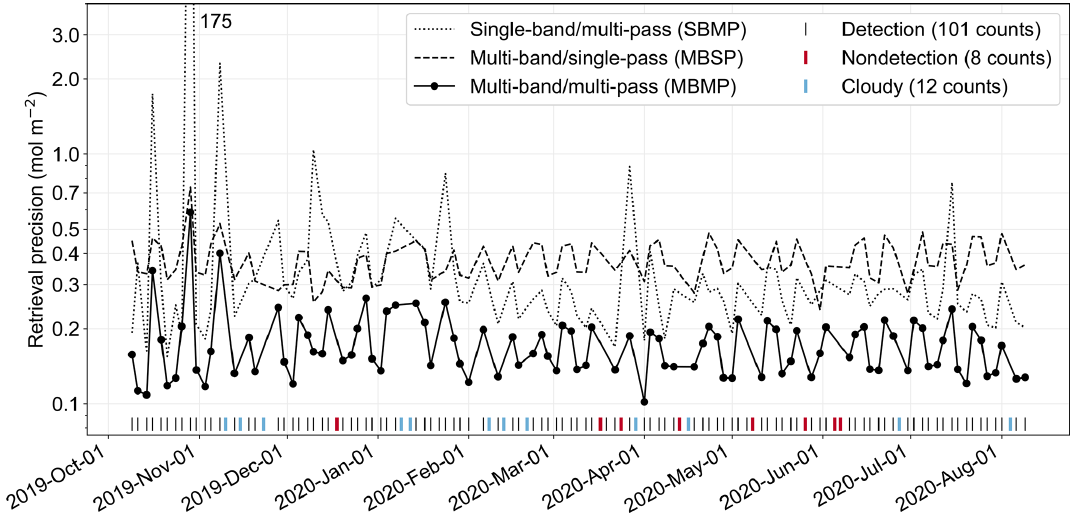
Figure 5. Single-pixel retrieval precision for the Hassi Messaoud scene over time, evaluated from the standard deviation of non-plume enhancements retrieved across the scene. The black, red, and blue markers indicate which satellite passes had plume detections, which had non-detections, and which were obscured by clouds, respectively. The y -axis is